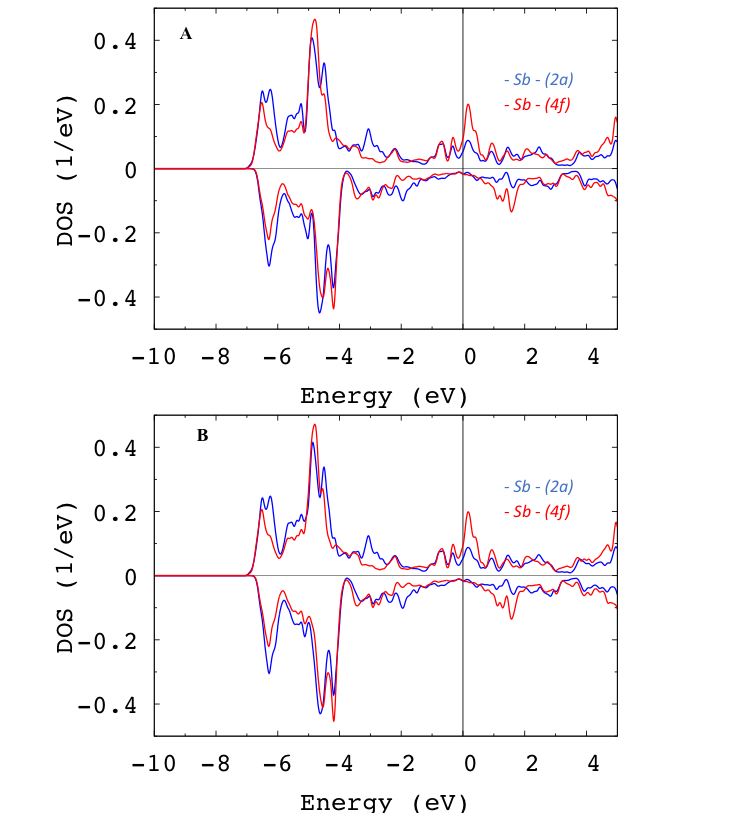
Figure 4. ( A ) Spin-projected p -DOS for M || [0001]; ( B ) spin-projected p -DOS for M || [1100] for Sb atoms in (2a) and (4f) Wyckoff positions. The Fermi level E F is set to E F =